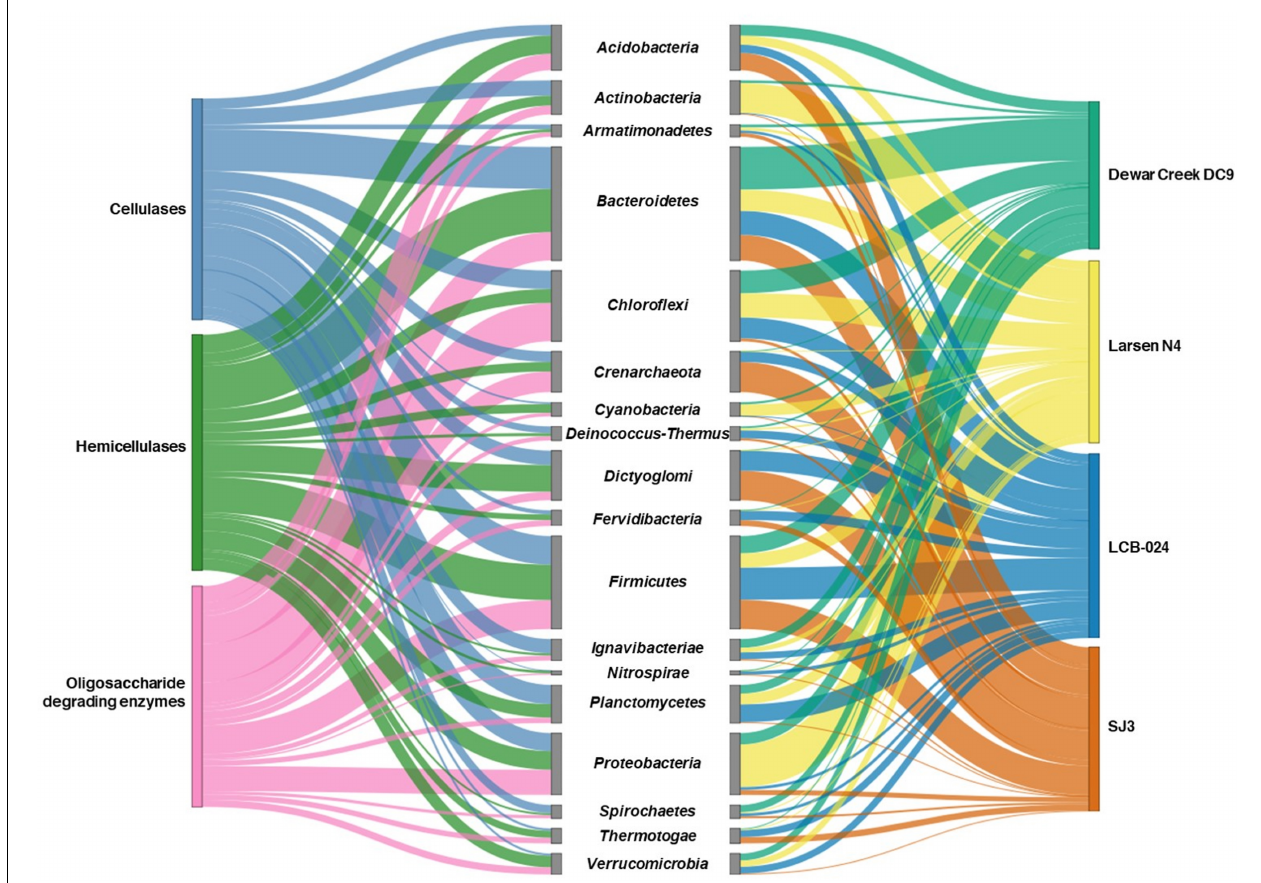
FIGURE 4 | Sankey diagram illustrating taxonomic distribution of CAZyme-containing contigs and the hot spring metagenomes they originated from. Indicated on the left is the enzyme type determined by the most abundant Pfam domain for the most abundant glycosyl hydrolase family for contigs identified by dbCAN2 using the CAZy database (Pfam00150—GH5—Cellulase, Pfam00331—GH10—Hemicellulase, Pfam00933—GH3—Oligosaccharide-degrading enzymes). In the center is the taxonomic affiliation of the contigs determined by IMG. Taxonomically unclassified contigs were removed prior to plotting. Shown on the right is the hot spring metagenome location for the taxa. The height of the Sankey bars are assigned proportionately to the relative abundances of CAZyme-containing contigs and